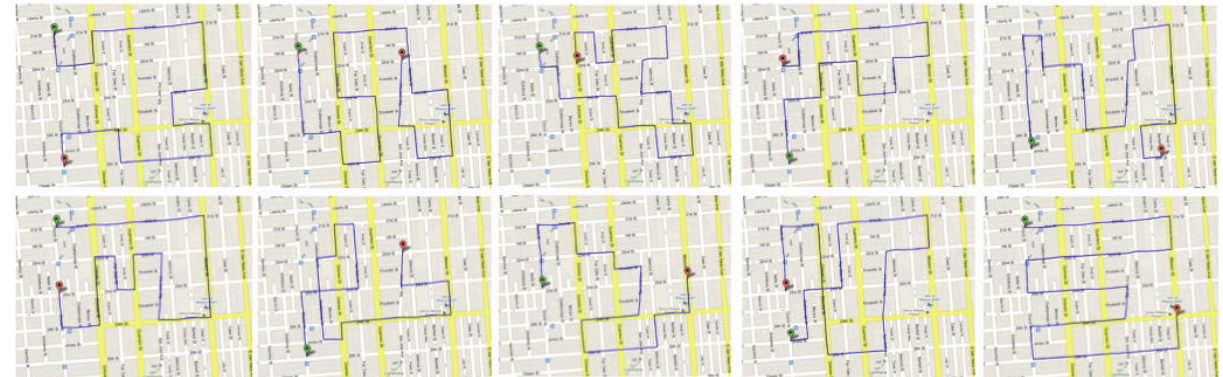
Figure 3: Moving paths of mobile vehicles (including the opposite direction as well). A total of 20 vehicles move over the network (as in Figure 2) at a constant speed of 30 km/h with regular time schedules while getting connected to stationary ad hoc nodes.